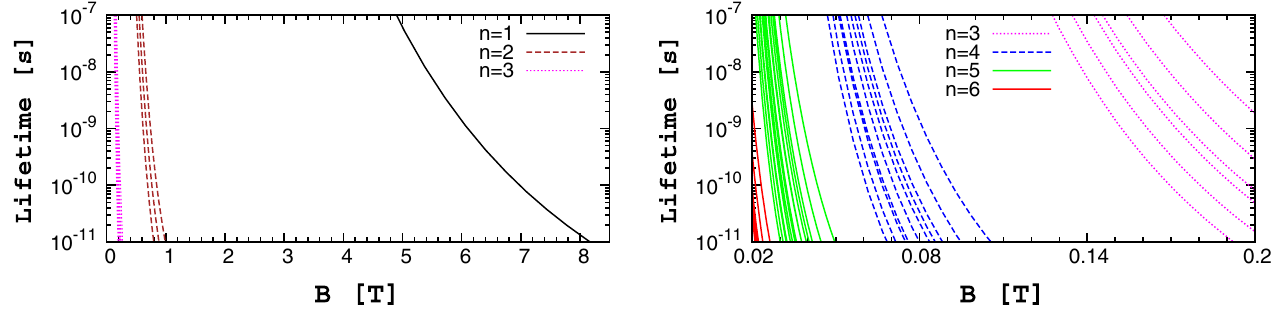
FIG. 12. Lifetime of various states of a neutral hydrogen atom in magnetic fields calculated in the laboratory frame for an atom with kinetic energy of 8